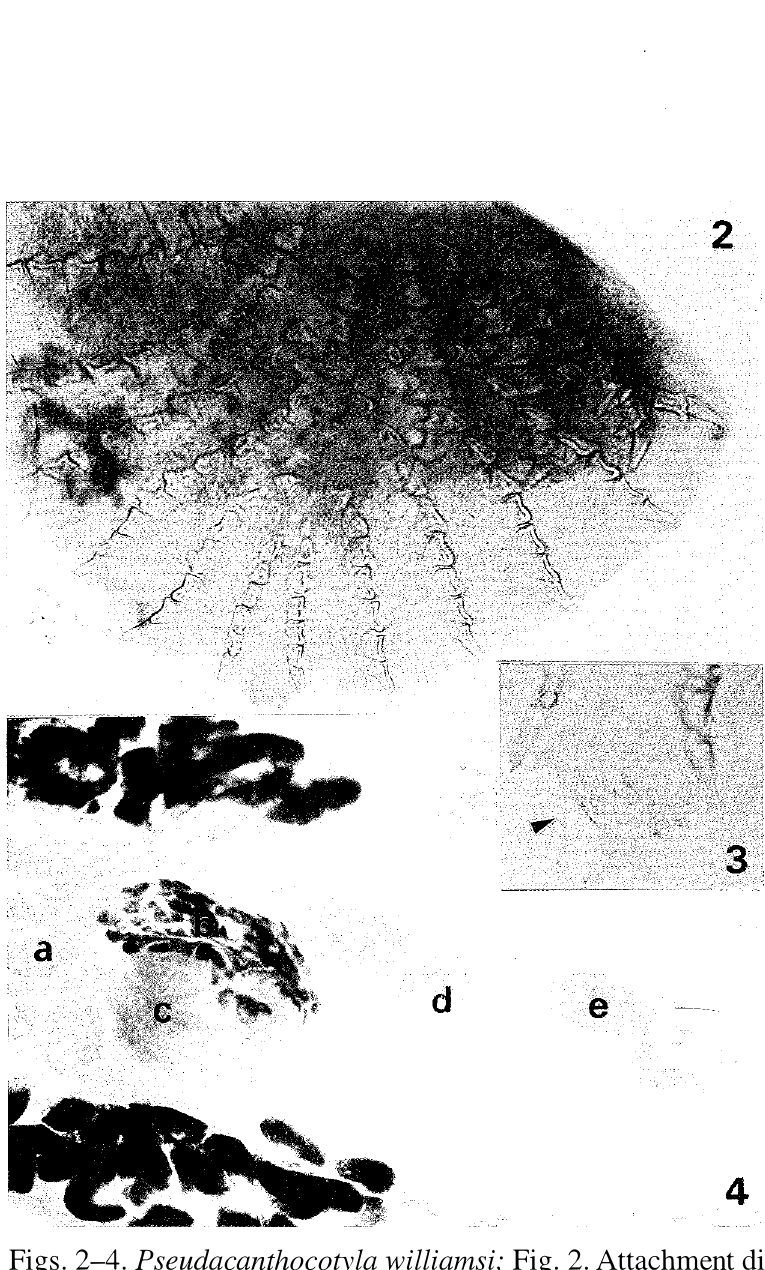
Figs. 2-4. Pseudacanthocotyla williamsi; Fig. 2. Attachment disc; Fig. 3. Part of attachment disc with small larval attachment organ (arrow); Fig. 4. Details of reproductive system; a, testes; b, ovary; c, receptaculum seminis; d, seminal vesicle; e, copulatory pouch; f,